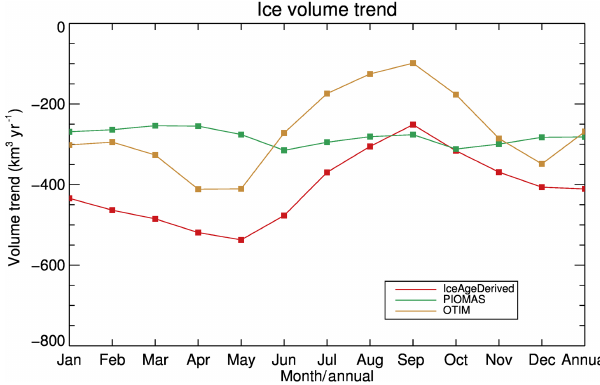
Figure 20. The portion of the trend in Arctic Ocean ice volume attributable to changes in ice area and ice thickness derived from ice age, PIOMAS, and OTIM for each month and in the annual mean from 1984 to